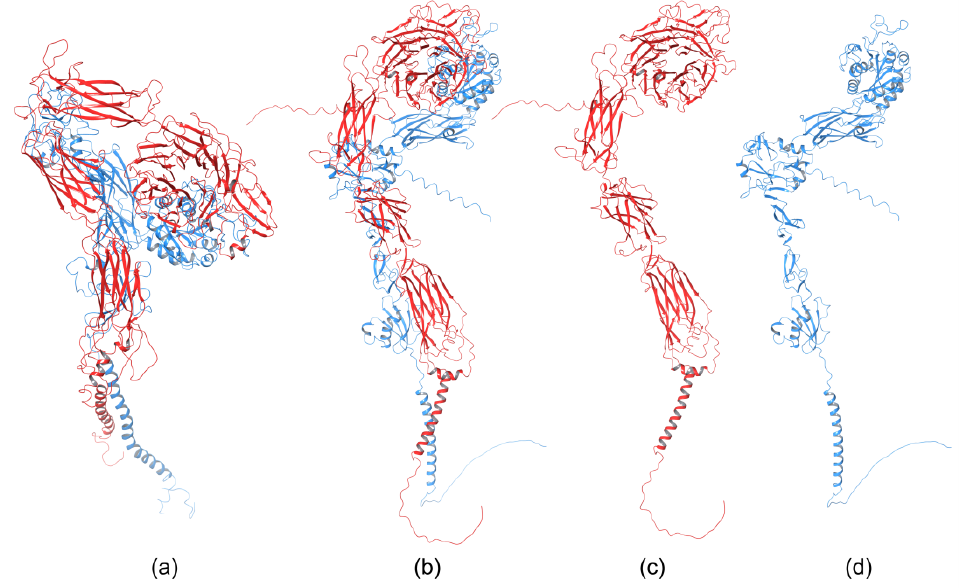
Figure 6. Homology model of ( a ) extended full-length integrin α IIb β 3 [179]; PM0076386 entry in PMDB database, the AlphaFold homology model of ( b ) α 4 β 1, ( c ) the α subunit of α 4 β 1, and ( d ) the β subunit of α 4 β 1